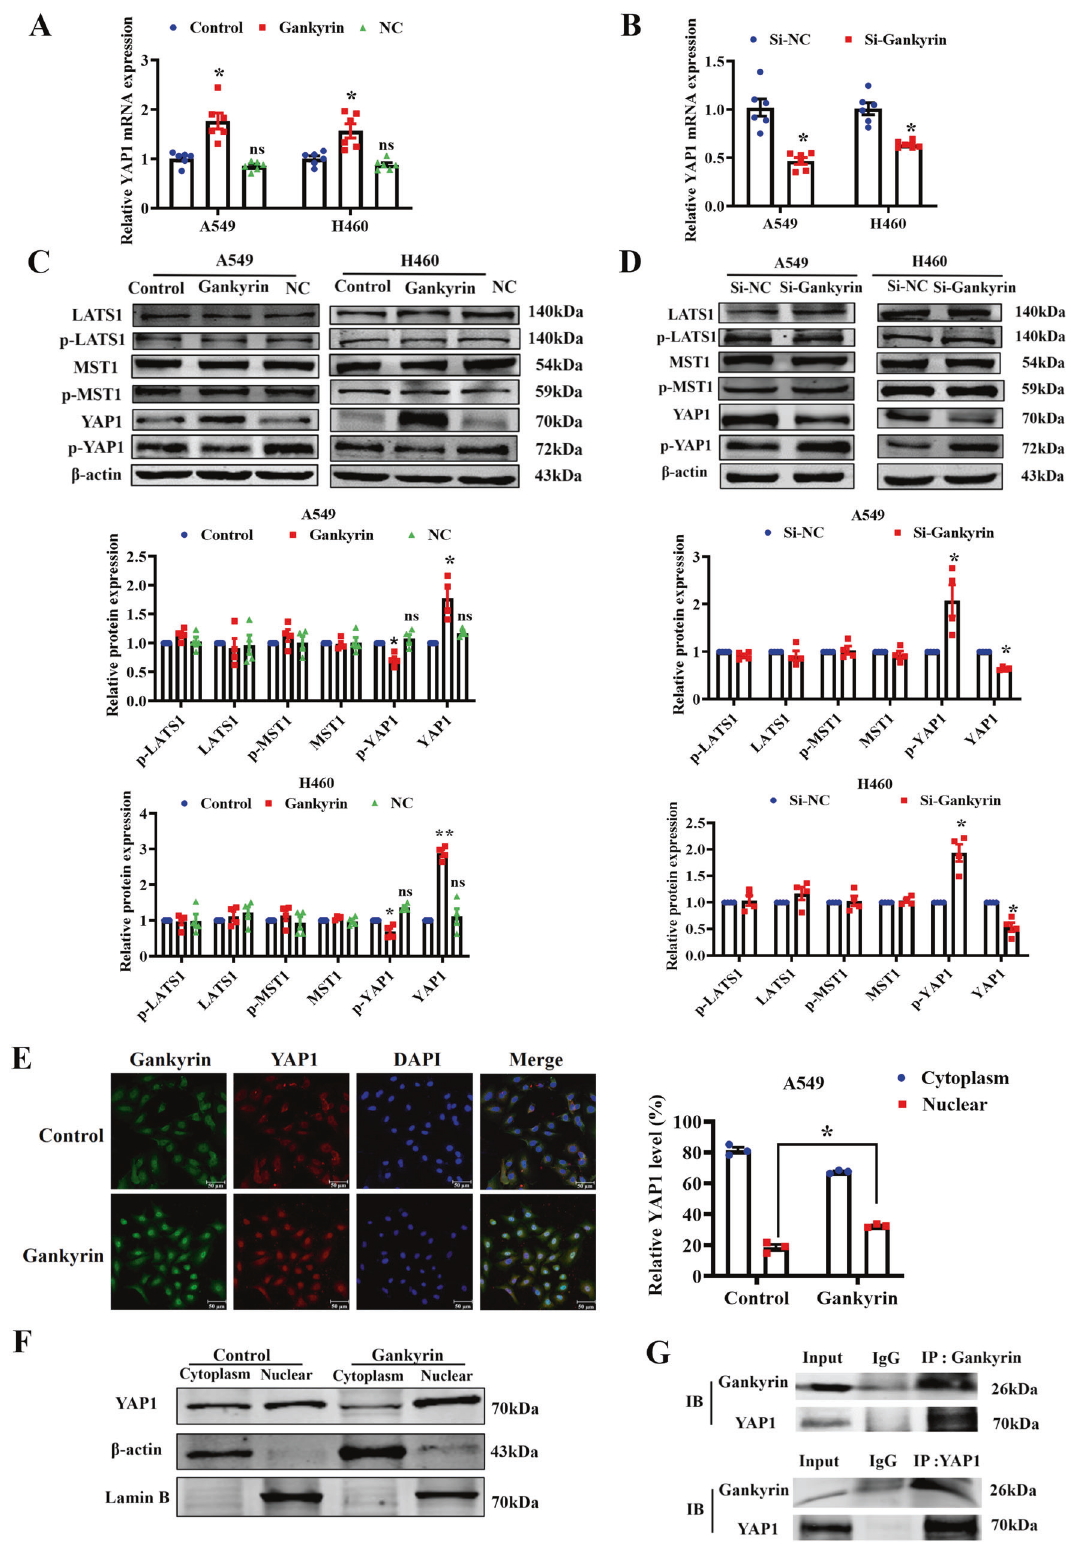
Fig. 4 Gankyrin promotes YAP1 nuclear translocation. A , B qRT-PCR assay results show the mRNA levels of YAP1 in A549 and H460 cells ( n = 6, * P < 0.05 vs . Control or Si-NC). C , D Western blotting assay results show the protein levels of LATS1, p-LATS1, MST1, p-MST1, YAP1, p-YAP1 in A549 and H460 cells ( n = 4, * P < 0.05, ** P < 0.01 vs . Control or Si-NC). E Representative immuno fl uorescence images of Gankyrin and YAP1 in A549 ( n = 3, * P < 0.05, Scale bars: 50 μ m). F Western blotting shows YAP1 expression in the nuclear fraction and cytoplasm of A549 cells. G Immunoprecipitation assay indicates interaction between Gankyrin and YAP1 in A549.